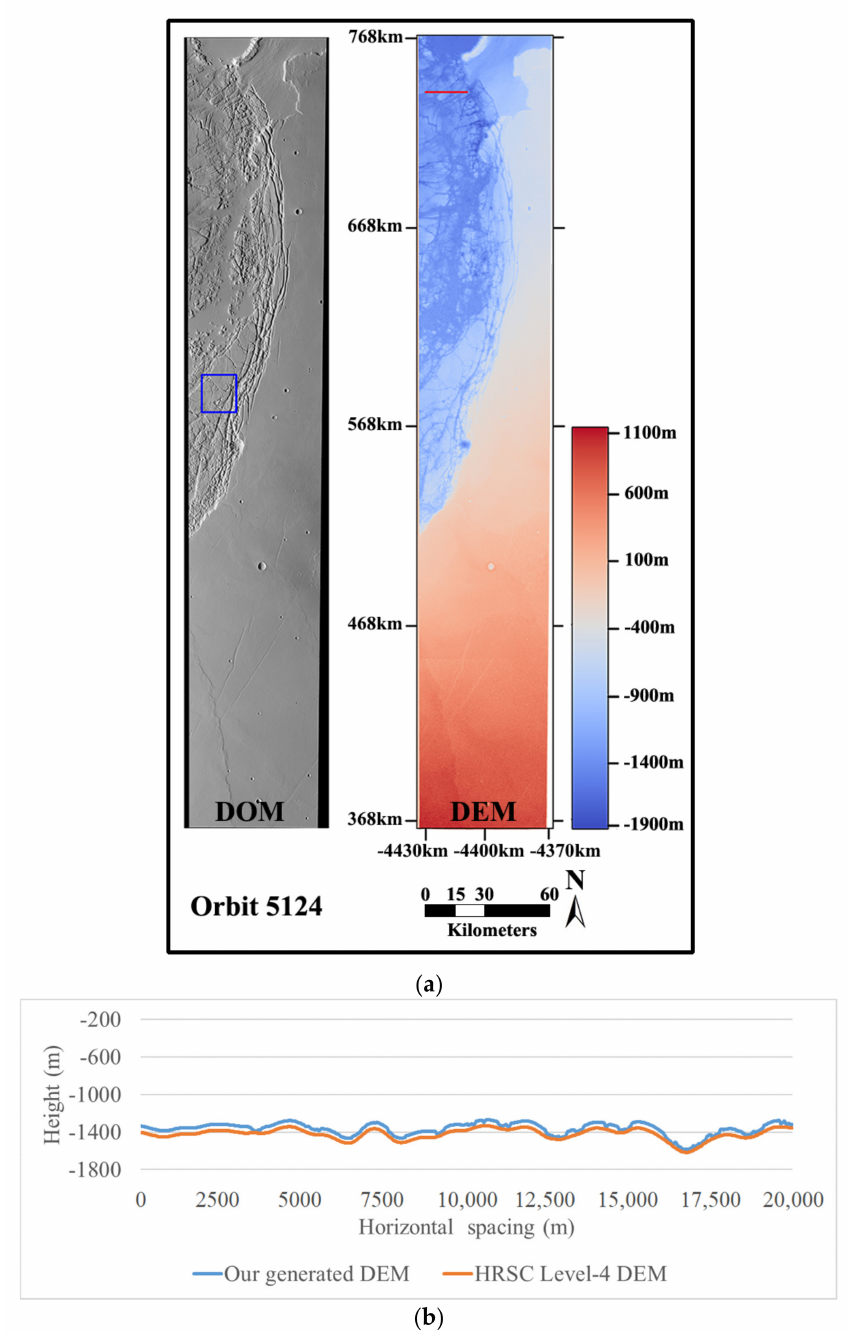
Figure 19. DEM results and terrain profiles comparison for orbit 5124: ( a ) DOM and DEM results; and ( b ) Terrain profile comparison between the generated DEM and the HRSC Level-4